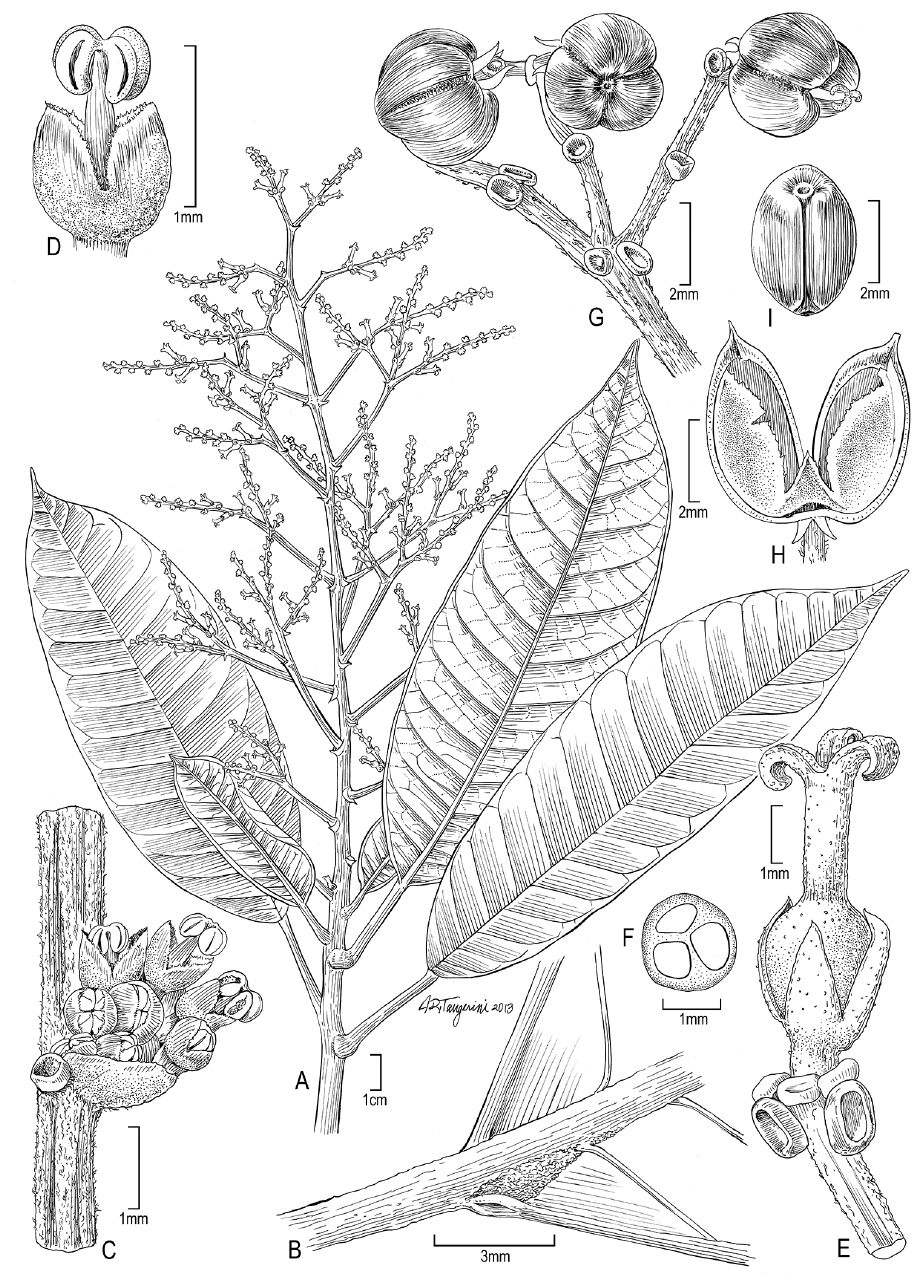
Figure 2. Illustration of Dendrothrix condorensis . A Habit B Leaf base (abaxial) showing basilaminar glands C Staminate cymule D Staminate flower E Pistillate flower F Cross section of ovary G Portion of infrutes- cence H Mericarp valve I Seed. (Source: A Neill et al. 15747 , MO and using life photos of this collection; B, E–F van der Werff et al. 16331 , MO; C–D, G Neill & Quizhpe 14939 , MO; H–I Neill et al. 15750 ,